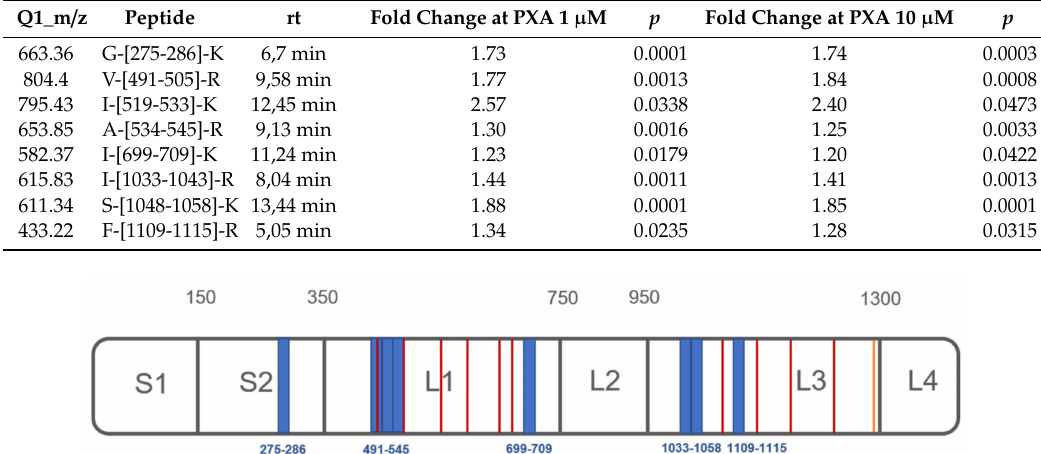
Figure 2. Schematic CPS1 cartoon covering di ff erent domains is depicted in gray, with the LiP-protected peptides highlighted in blue, ADP binding sites residues in red (T502, E503, R505, M543, R545, E581, K582, V584, E589, M614, H617, Q658, E672, N674, R676 and R679, R1087, K1126, V1128, E1133, H1160, Q1201, E1213, R1217, R1220), and T’-loop in orange